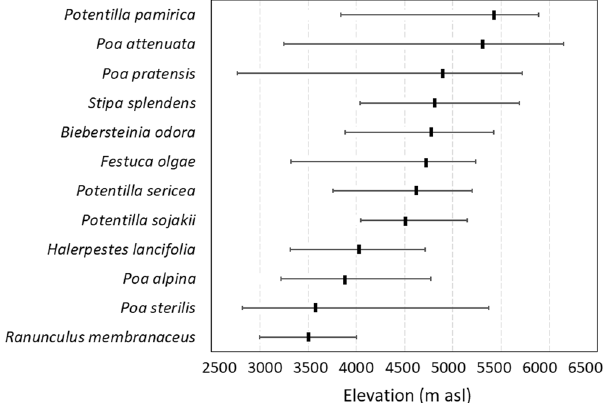
Figure 2. Apomictic species and their elevation optima and ranges in Ladakh, NW Himalayas. Note that it spans the whole range of elevations in the area and the apomictic species are not concentrated in higher